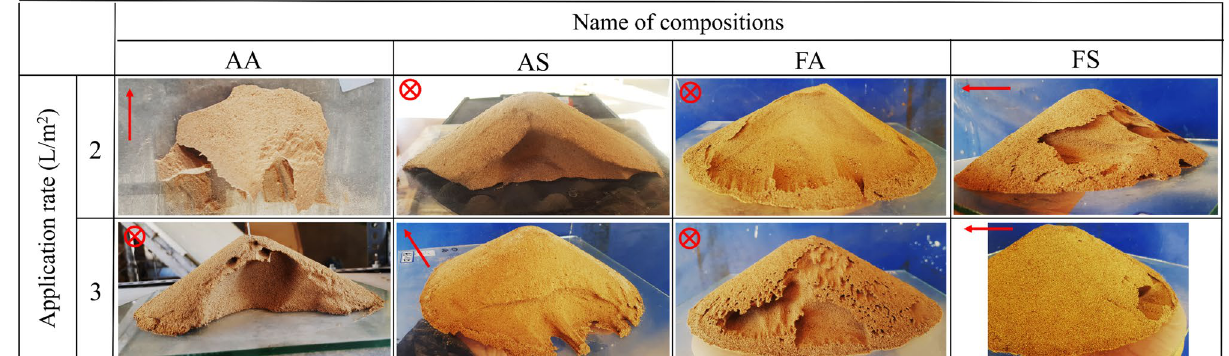
Figure 10. Treated sand dunes after sand bombardment for different compositions at 2 and 3 L/m 2 application rate (the arrows indicate wind direction, and the cross denotes wind direction perpendicular to the figure